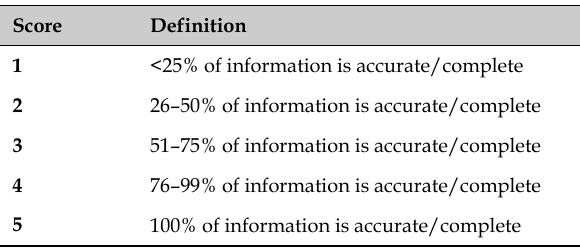
Table 1 Rating scale to assess accuracy and